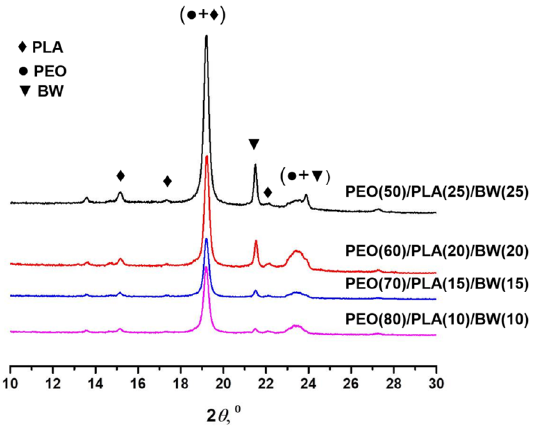
Figure 7. XRD patterns of materials prepared at different ratios of PEO/PLA/BW.